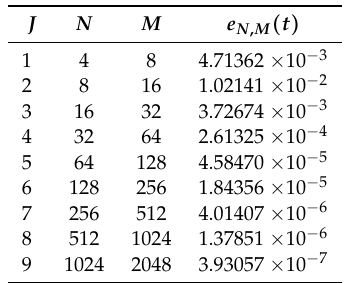
Table 2. Maximum estimated absolute errors for α = 1